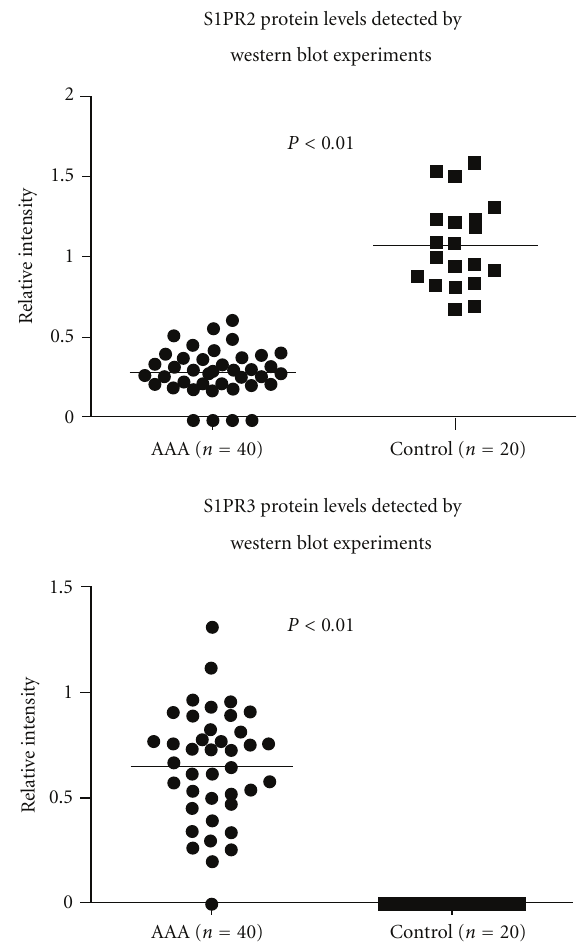
(lower panel) protein expression levels in western blot analysis. The relative S1P2 protein level was decreased by 73% ( P < 0 . 05) in AAAs (relative expression intensity of 0.29) compared with normal aortas (relative expression intensity of 1.08). S1PR3 protein levels were significantly upregulated in AAA tissues with average relative intensity of 0.65, whereas it was undetectable in normal